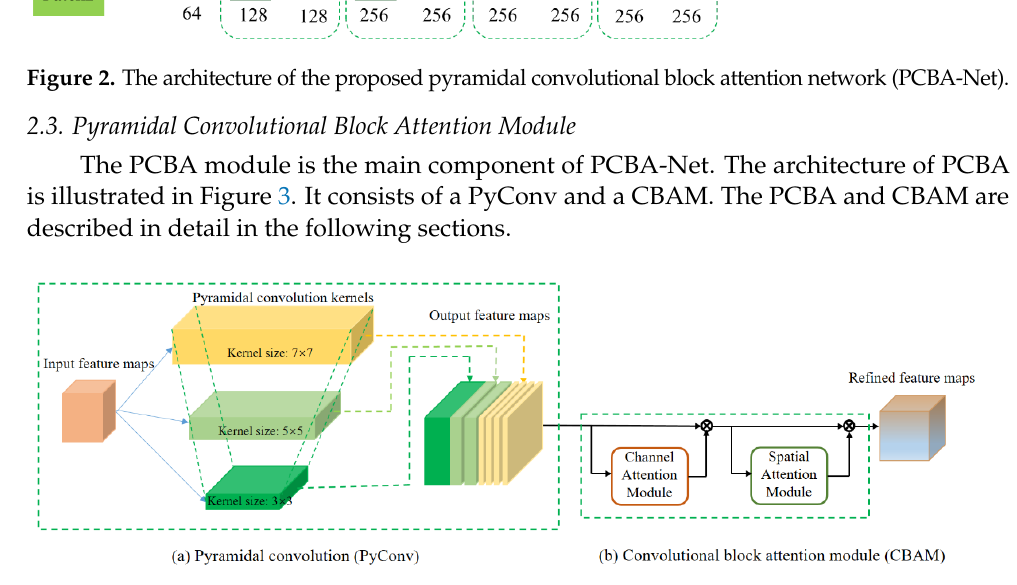
Figure 3. Sketch of PCBA architecture.